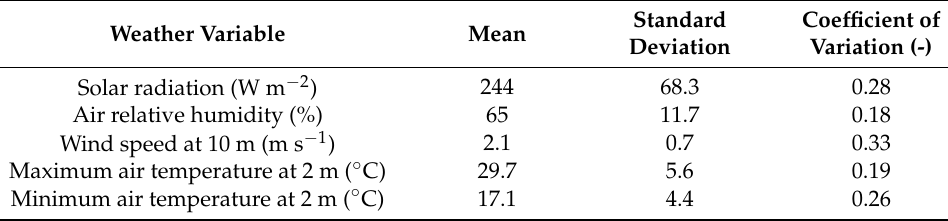
Table 2. Irrigation schedule and